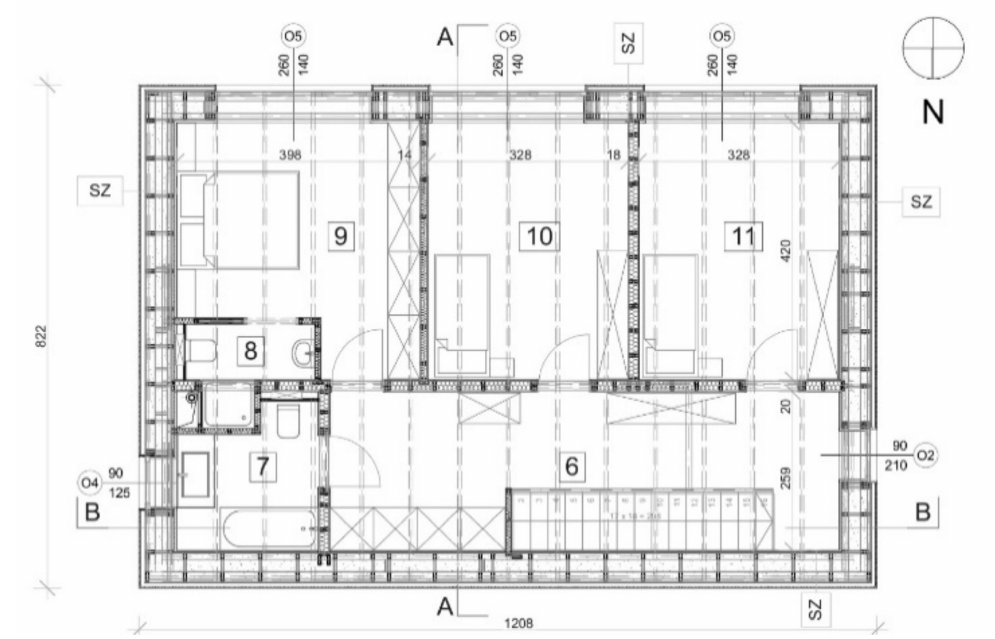
Figure 8. Model A2SB. Floor plan. Scale of 1:100. Source: own study using ARCHICAD